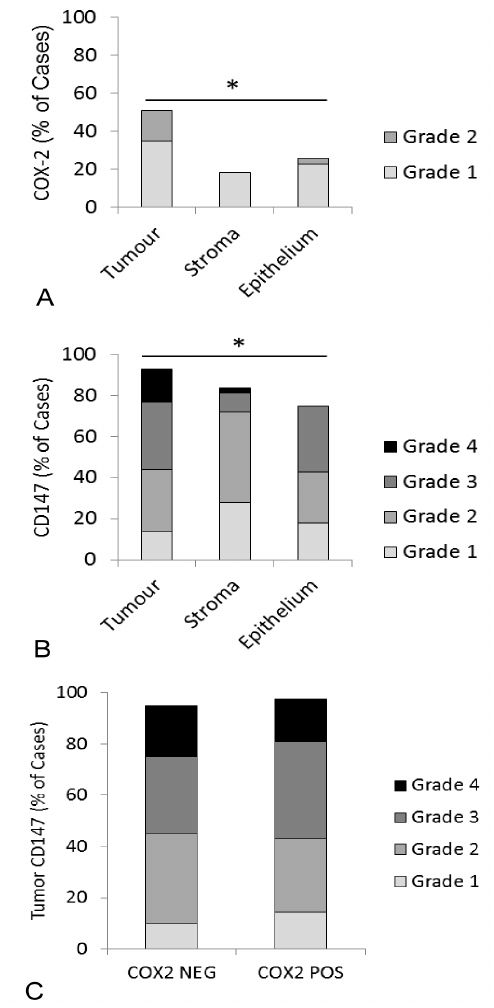
Figure 3. Expression of COX-2 and CD147 in feline OSCC samples using an IHC grading system. ( A ) COX-2 staining results were obtained from 43 samples, 31 of which included adjacent oral epithelium. Each bar represents the percentage of cases that were considered positive for COX-2 expression within each compartment (tumor cells, stroma, and adjacent epithelium). Each bar is subdivided to demonstrate the percentage of cases assigned to each grade. COX-2 expression was highest in the tumor cells. ( B ) CD147 staining results were obtained from 43 samples, 28 of which included adjacent oral epithelium. CD147 expression was highest in the tumor cells. ( C ) Paired COX-2 and CD147 IHC results were available from 42 OSCC cases. Twenty-two (22) cases had positive COX-2 expression in the tumor cells (grades 1 and 2) and 20 cases were COX-2 negative in the tumor cells (grade 0). Each bar represents the percentage of positive CD147 cases within the COX-2 positive and COX-2 negative groups. There was no significant difference in CD147 expression between COX-2 positive and COX-2 negative cases. There were no cases with grade 5 staining. All of the statistical comparisons were made using Fisher’s exact test (* p value <